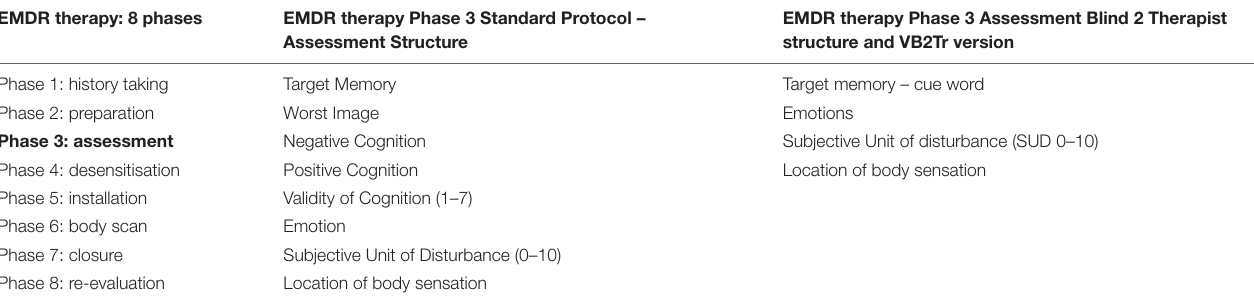
TABLE 2 | EMDR Blind 2 Therapist protocol in context, adapted from Wolpe and Lazarus (1966), Shapiro (2018, 1995, 2001), and Farrell et al. (2020). EMDR therapy: 8 phases EMDR therapy Phase 3 Standard Protocol – Assessment